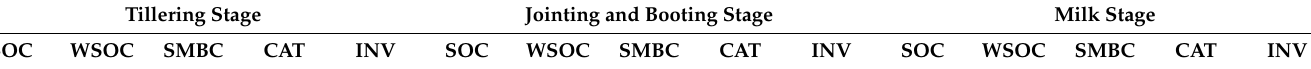
Table 6. Pearson correlation coe ffi cients of SOC and its components with soil enzyme activities at di ff erent growth stages of rice. Growth Period Tillering Stage